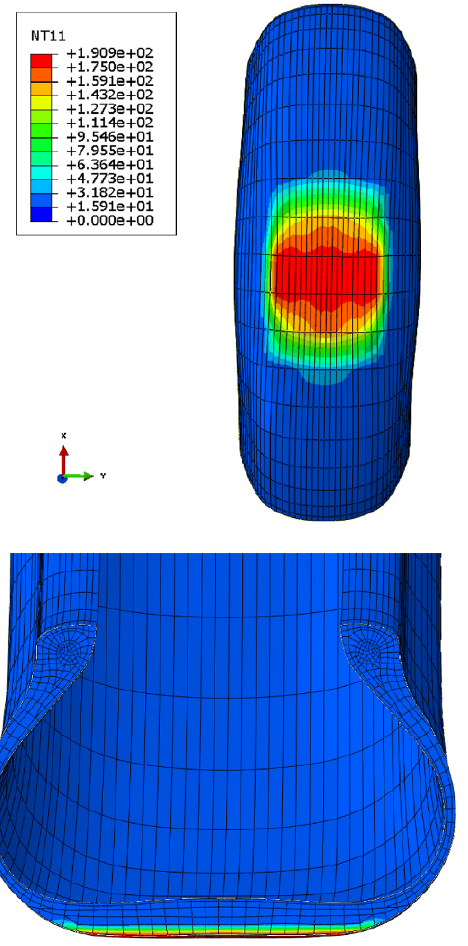
Figure 18. Temperature gradient in a pure sliding simulation at 50 km/h .